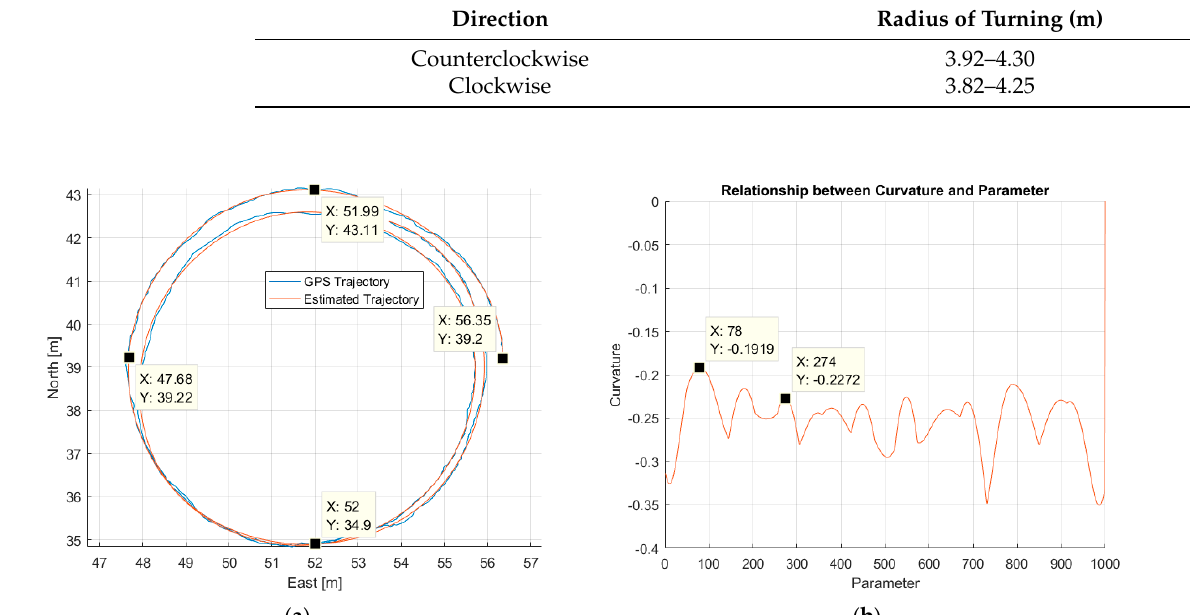
Figure 13. Approximately interpolate B-Spline curve from GPS data in ( a ); curvature analysis of USV2000 in ( b ).